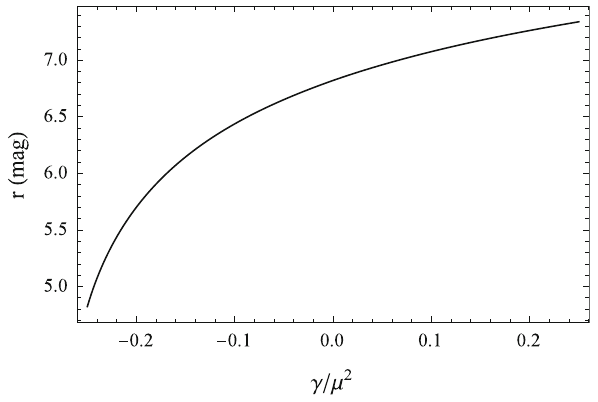
Fig. 2 Difference in magnitude r between the first relativistic image and the sum of the rest as a function of γ/μ 2